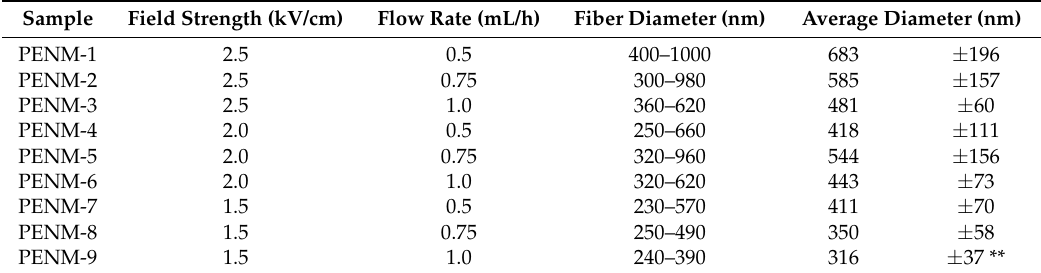
Figure 2. Scanning electron microscope (SEM) nanofibers of ( a ) PENM-1; ( b ) PENM-2; ( c ) PENM-3; ( d ) PENM-4; ( e ) PENM-5; ( f ) PENM-6; ( g ) PENM-7; ( h ) PENM-8 and ( i ) PENM-9. Table 2. The average diameter of the polyvinyl alcohol electrospun nanofibrous membranes